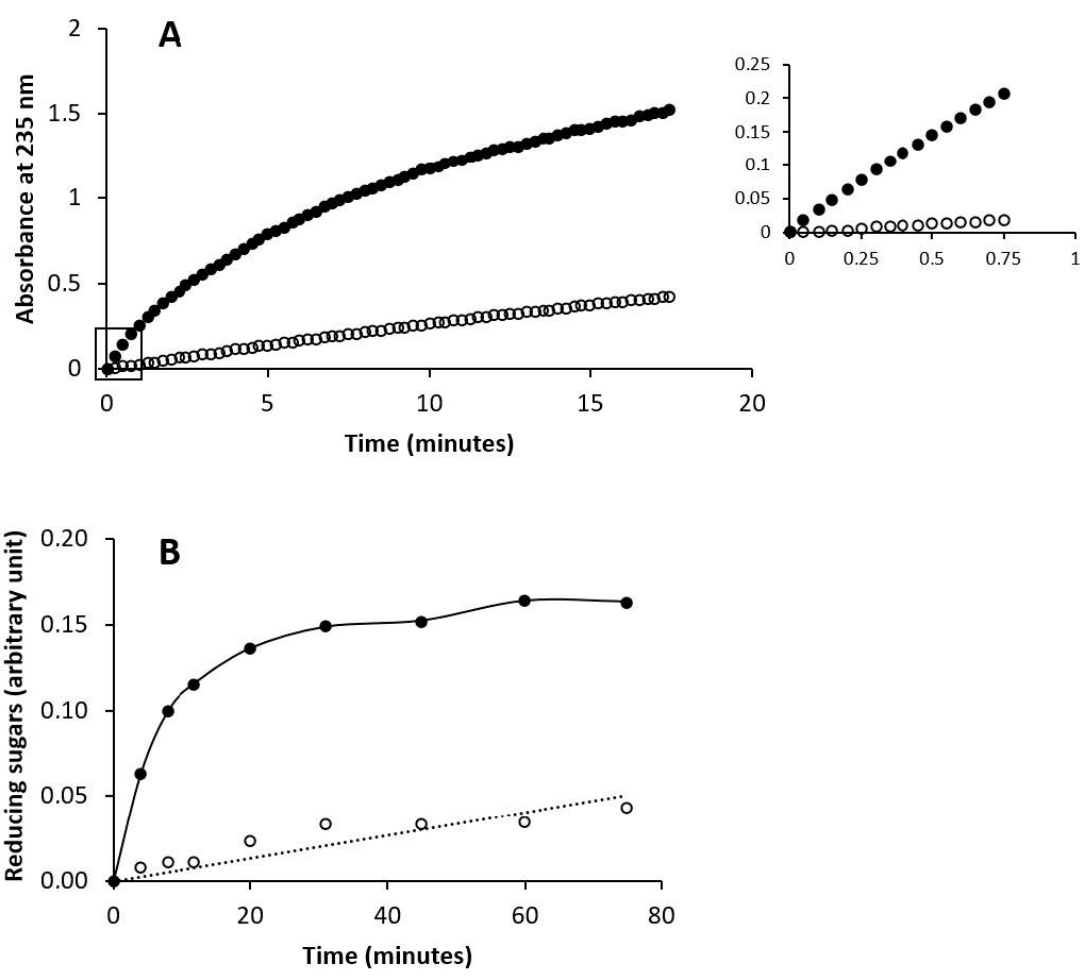
Figure 6. Enzymatic digestion of chondbiuronan and chondroitin by chondroitin AC lyase ( A ) and by hyaluronidase ( B ). The filled or hollow circles represent activity on chondroitin and chondbiuronan respectively. A 235 is proportional to the concentration of unsaturated non reducing ends formed by the lyase action. Hyaluronidase activity was followed by measuring reducing sugars released from substrates with the ferricyanide method.